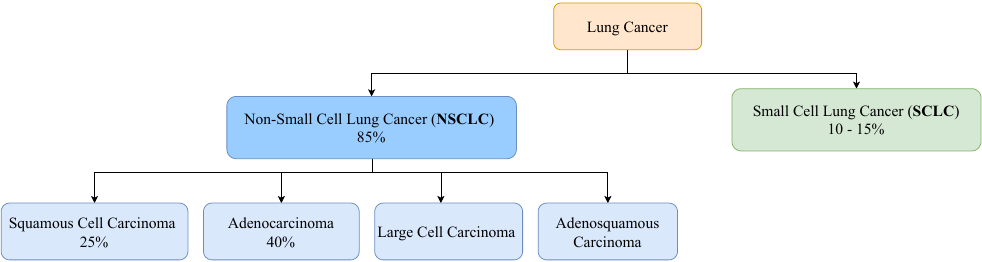
Figure 1. Prevalence of the major histological subtypes of lung cancer: non-small cell lung cancer and small cell lung cancer